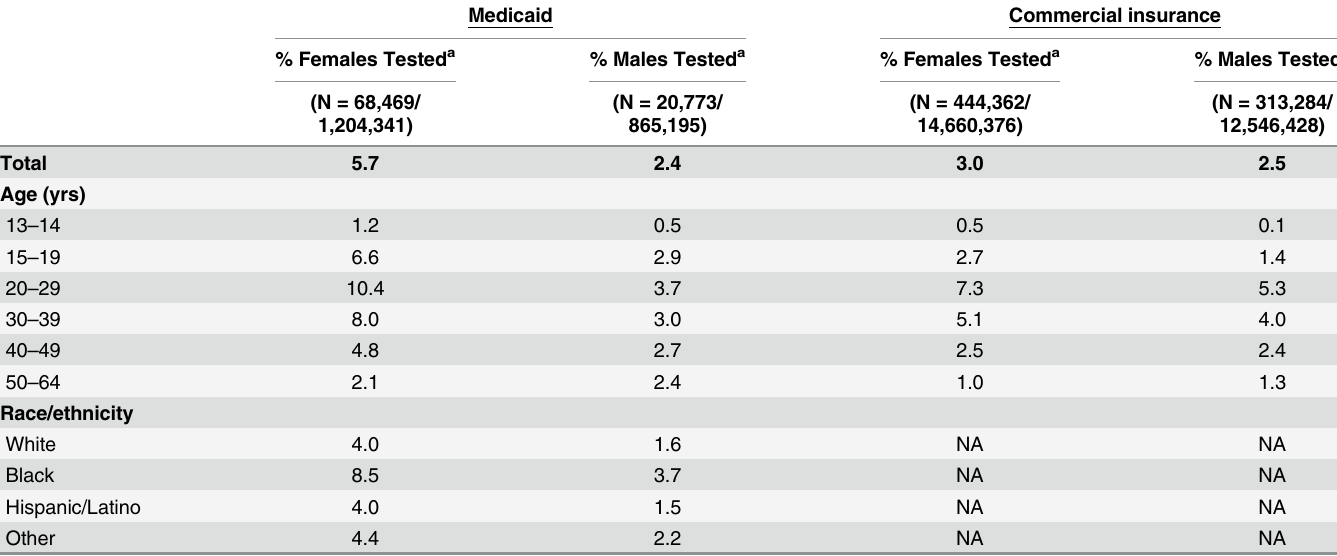
Table 3. HIV tests by demographic characteristics and type of healthcare coverage among females and males.